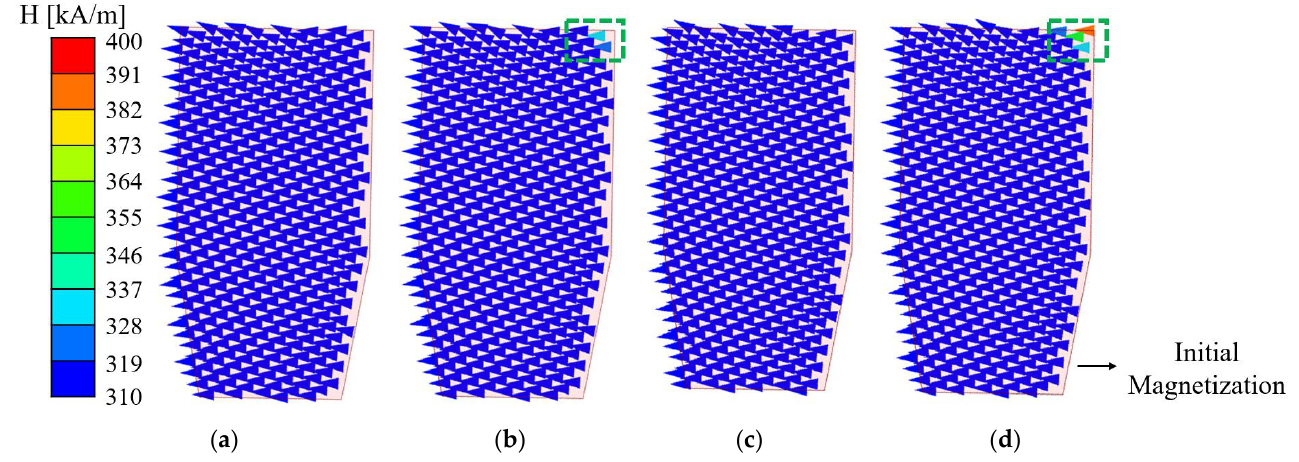
Figure 18. Magnetic field ( H ) distribution of 6Φ -SS-FSCW-Fer-SIPMSM at − 40 °C when the motor current was ( a ) 2.6× and ( b ) 2.8× rated current, and 80 °C when the motor current was ( c ) 2.6× and ( d ) 3.4× rated current.